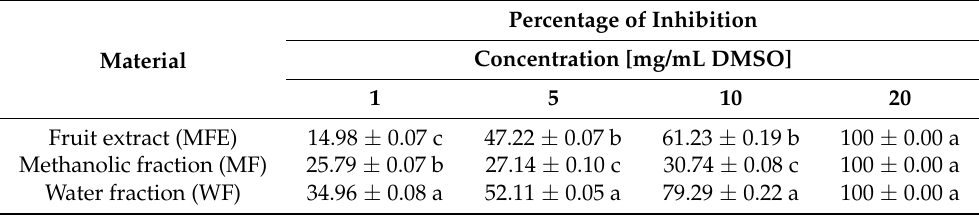
Percentage of Inhibition